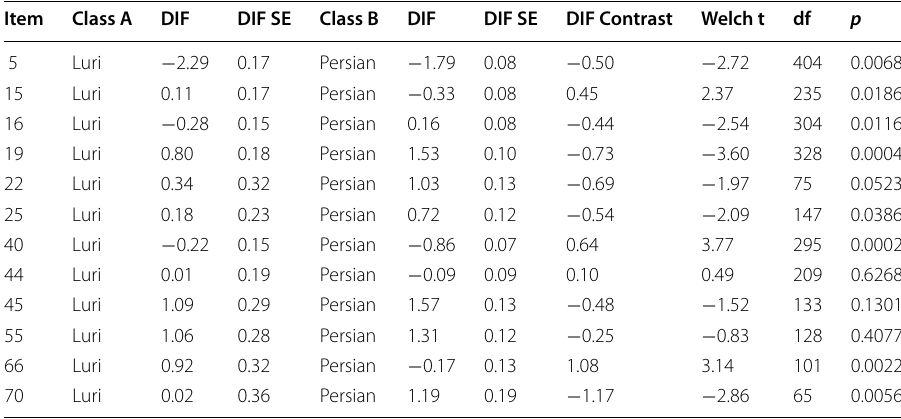
Table 14 Results of uniform DIF analysis of items (IUUESEE 2019)